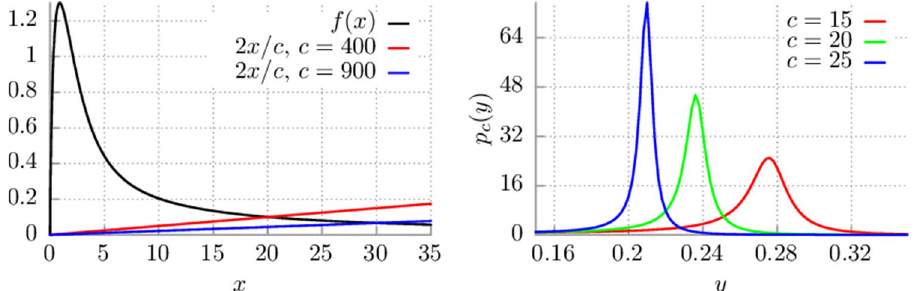
Figure 4. Left panel. Black: the function f ( x ) defined in Eq. (52). Red and blue: the straight line 2 x / c for c = 400 and c = 900 , respectively. The intersection of the curves is a root of the equation g ( x ) = 0 defined in Eq. (52). Right panel. Example of three terms of the Dirac δ -sequence p c ( y ) defined in Eq.